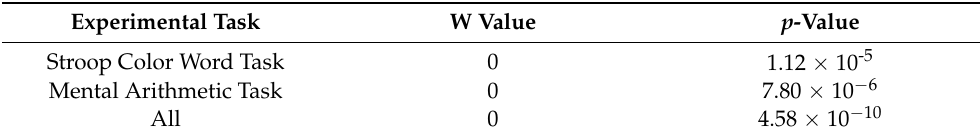
Table 2. The results of the Wilcoxon signed-rank test performed on the responses of the self-report questionnaires. W value indicates the sum of the ranks of the differences above or below zero and p-value is calculated under the null hypothesis that the data are not statistically significant. The test was used to compare the control and stress states of each of the experimental tasks. The questionnaire responses for the two states were also summed for both the tasks, so that an overall validation of the experimental protocol could be conducted.